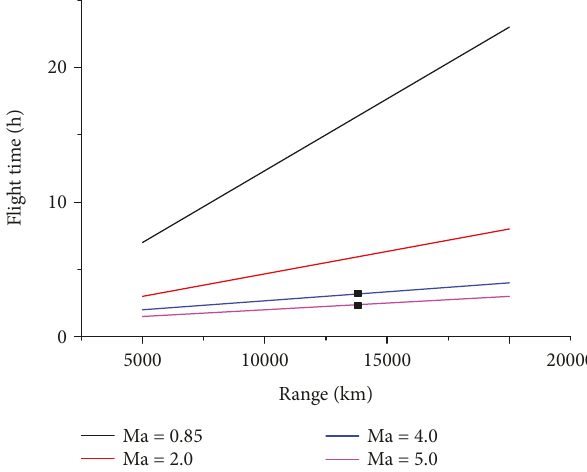
Figure 3: The fl ight time contrast at di ff erent